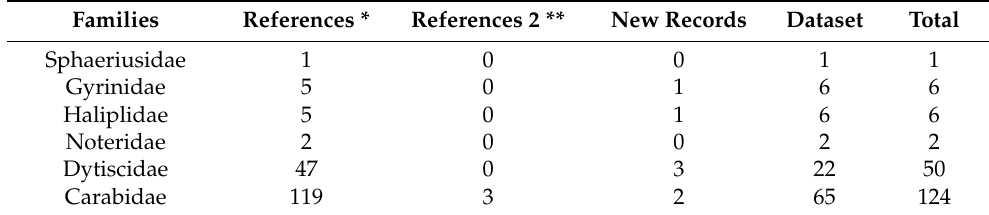
Table 2. Species diversity of beetles of the Khvalynsky National Park.